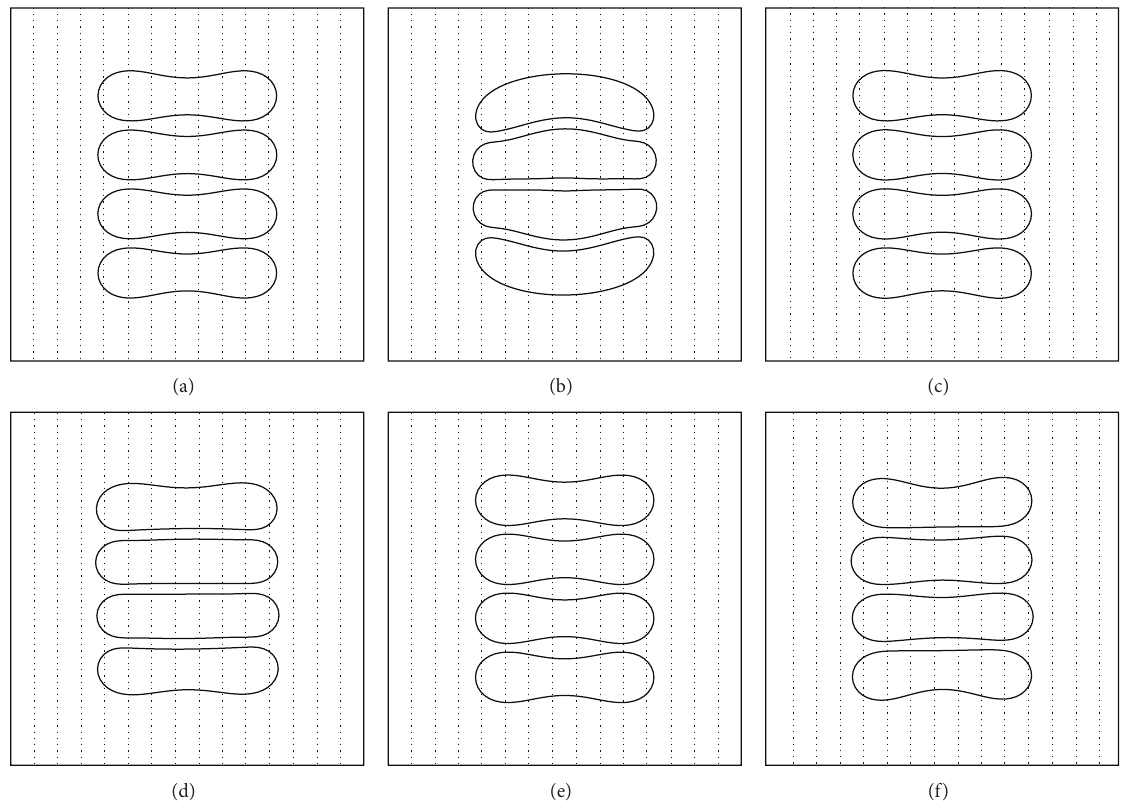
Figure1:Equilibriumconfigurationoffour-cellrouleauobtainedunderno-flowconditionwithdifferentintercellularstrengthandmembrane deformability. The cells are placed at the center of a 15 𝜇 m by 15 𝜇 m square domain filled with blood plasma. The parameters used are (a) = 1.0 × 10 −2 𝜇 J/m 2 , 𝑘 = 1.0 × 10 −13 Nm; (b) 𝐷 = 1.0 𝜇 J/m 2 , 𝑘 = 1.0 × 10 −13 Nm; (c) 𝐷 𝐷 𝑒 𝑏 𝑒 𝑏 = 1.0 𝜇 J/m 2 , 𝑘 = 5.0 × 10 −13 Nm; (e) 𝐷 = 1.0 × 10 −2 𝜇 J/m 2 , 𝑘 = 3.0 × 10 −12 Nm; and (f) 𝐷 𝐷 𝑒 𝑏 𝑒 𝑏